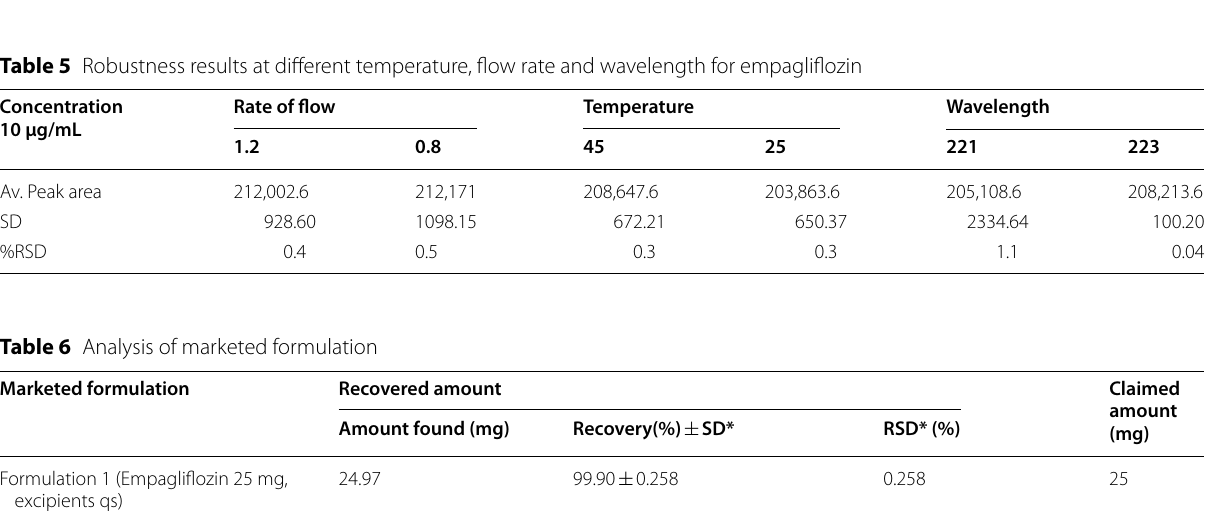
*Average of three determinations of three different concentration